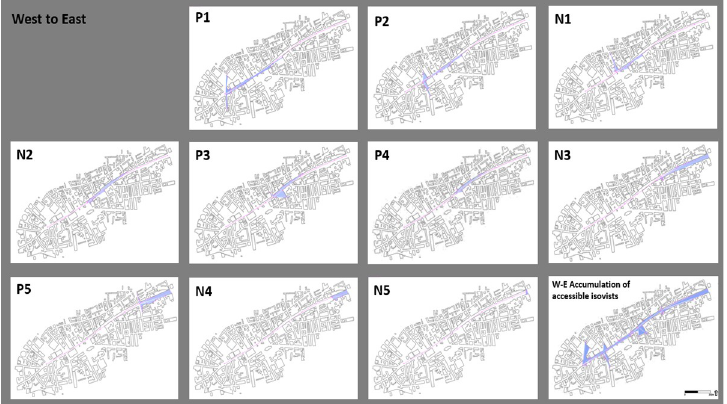
Fig 4. West to East: Accessible isovists by points and their